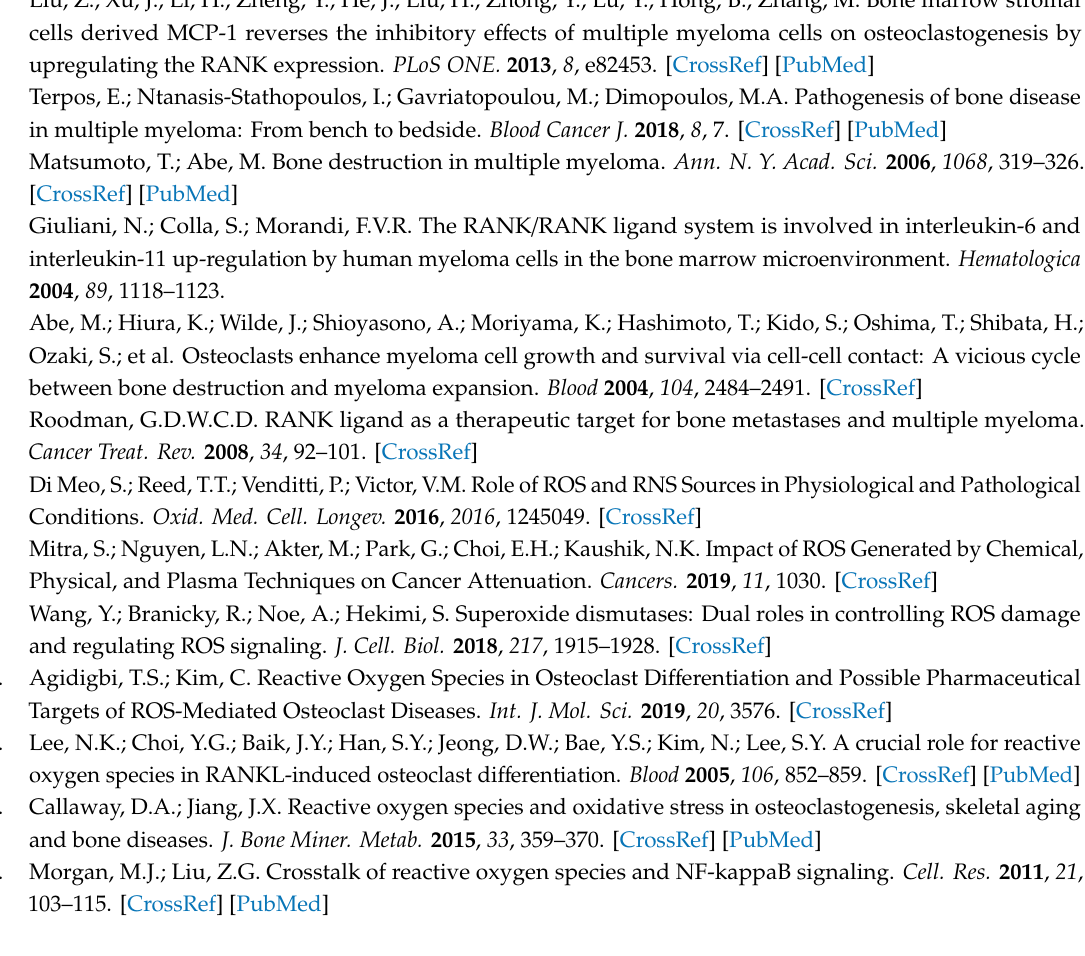
Figure S1: NFATc1 mRNA expression by febuxostat, Figure S2: Bone resorption activity, Figure S3: The e ff ects of febuxostat on early and late phases of OC di ff erentiation, Figure S4: ROS production in MM cells by DOX, Figure S5: Viability of mature OCs by Dox, Figure S6: PIM2 expression in OCs, the whole images of each Western blotting membrane are in the supplementary